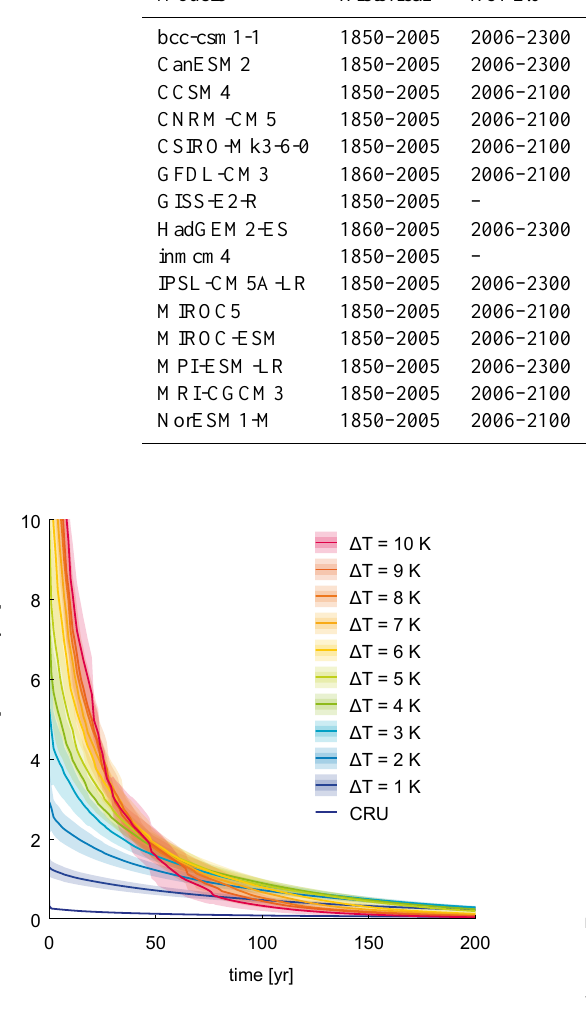
Fig. 1. Rates of global glacier-mass loss during the first 200yr of the equilibrium experiment (Fig. 2). Solid lines show model mean, shading indicates one standard deviation. Colors indicate global mean temperature anomaly applied. CRU corresponds to the exper- iment where the observed climatology is applied (i.e., 1T = 0K). The volume response within the first 200yr is generally > 95% of the total.